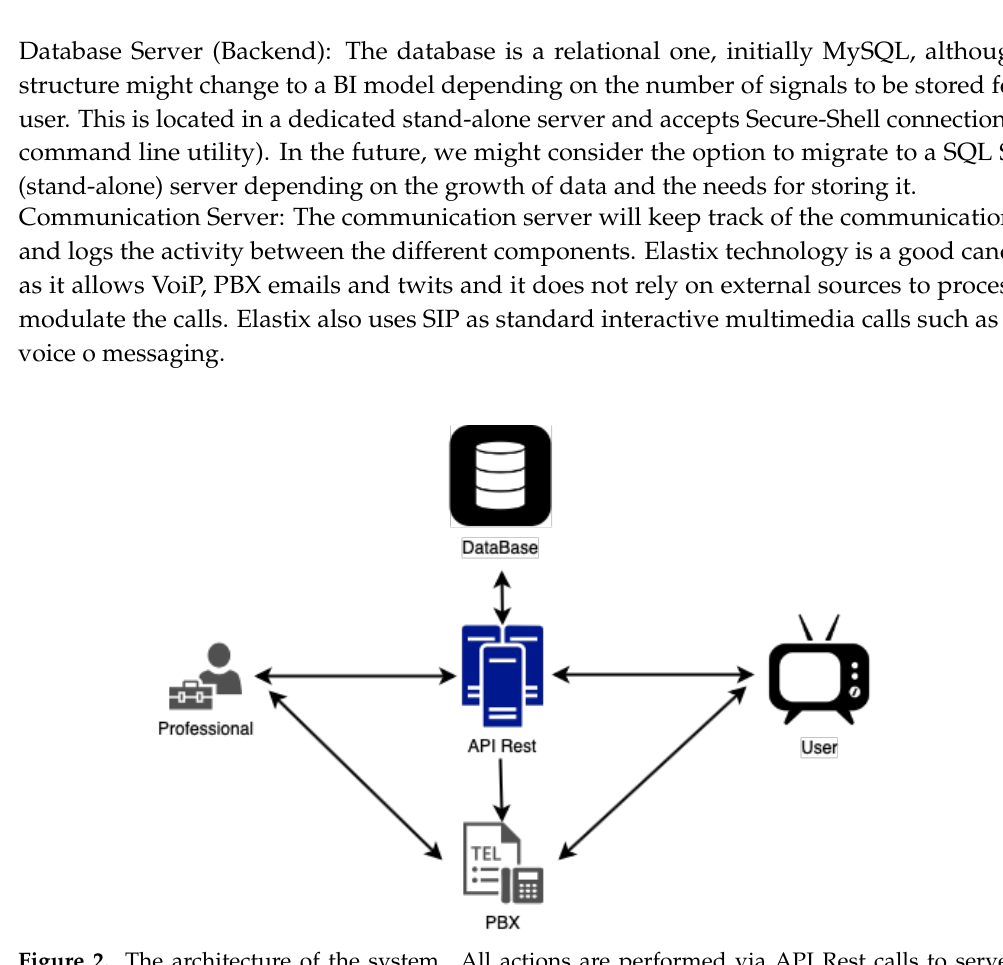
Figure 2. The architecture of the system. All actions are performed via API Rest calls to server (blue